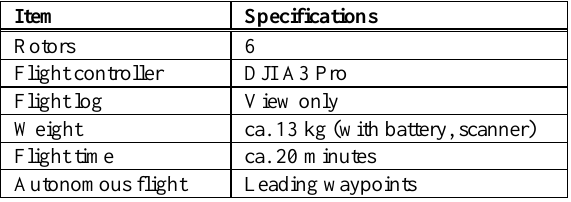
Table 1. UAV specifications